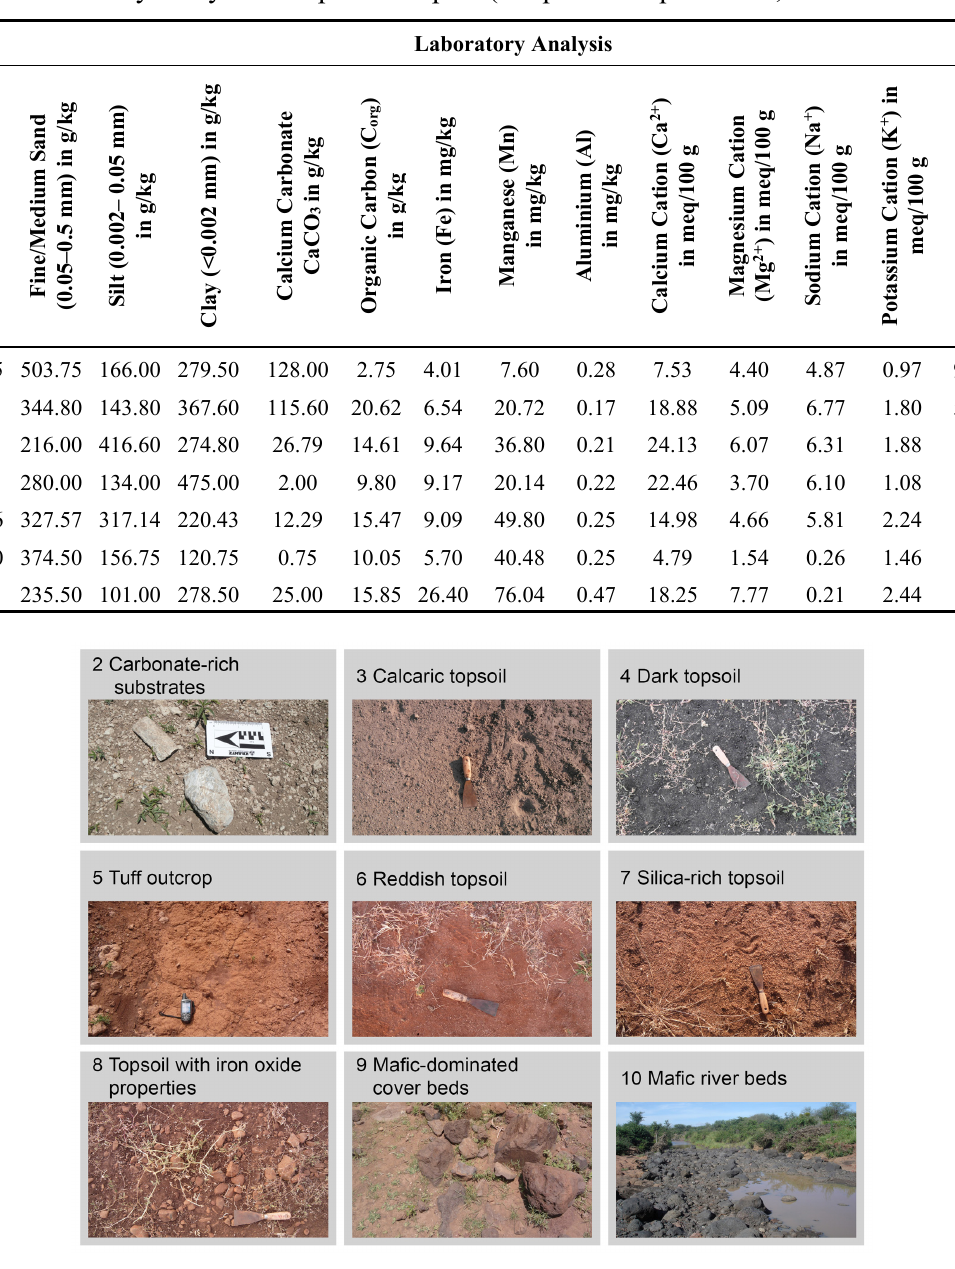
Table 5. Laboratory analysis of topsoil samples (meq = milliequivalents; mmol = millimoles).